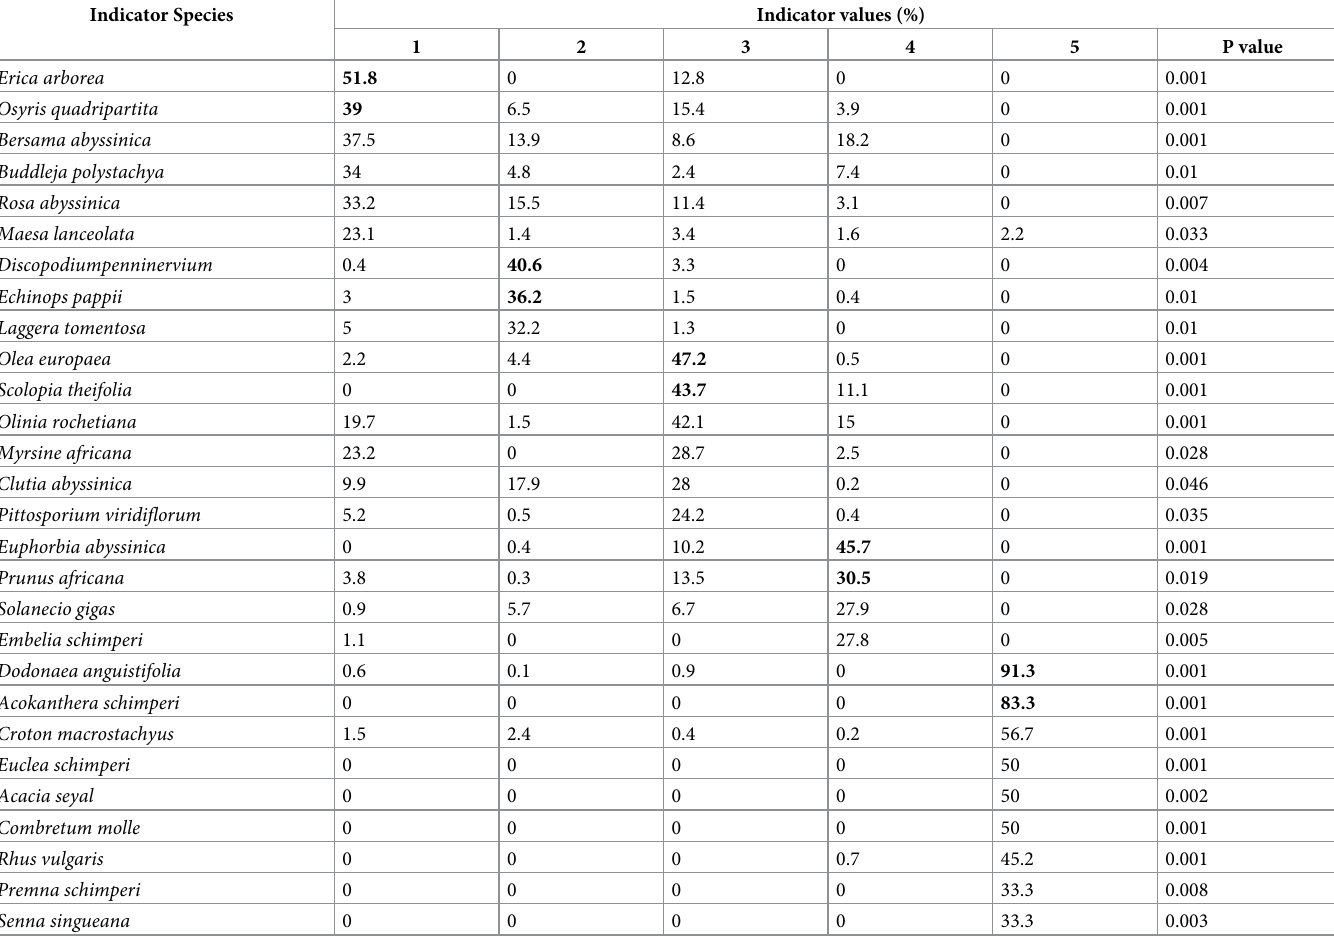
Table 3. Indicator values of species in each community type (C1—C5) and their significance ( P < 0.05). Indicator